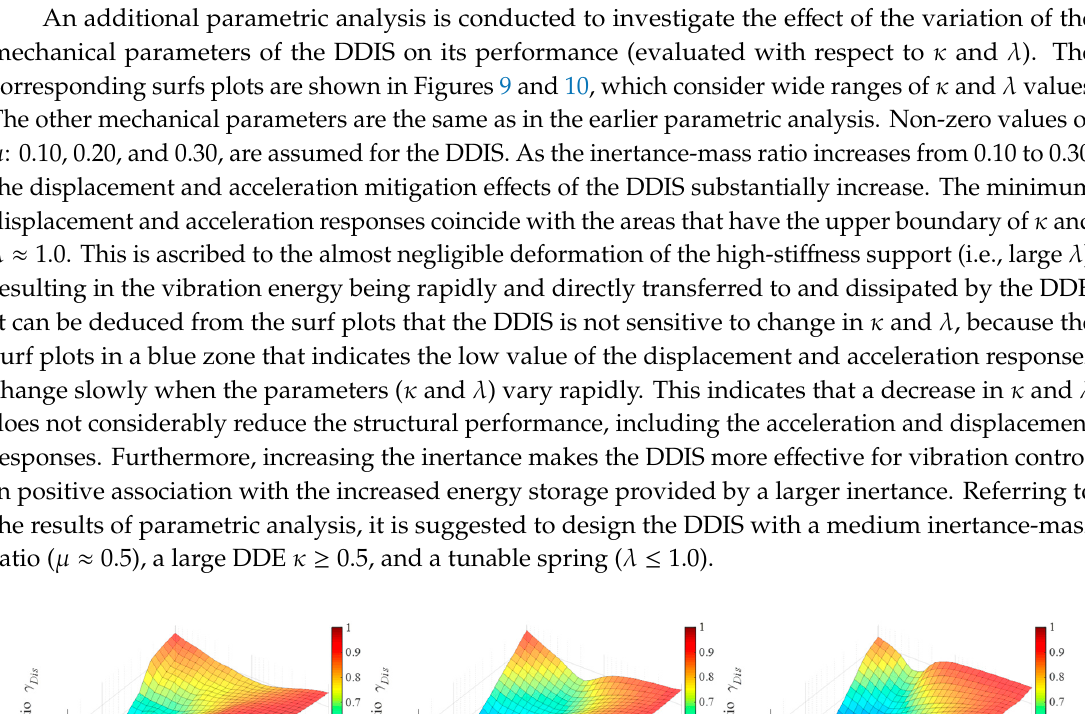
( c ) Figure 10. Variation of γ Acc for (a) μ= 0.10 , (b) μ= 0.20 , and (c) μ= 0.30 . 3.2.3. Influence of Structural Parameters Physical and model uncertainty of the primary structure may cause the practical behavior of the DDIS to deviate from theoretical expectations. The sensitivity of the vibration control effect of the DDIS to uncertainties of the primary structure is also worth analyzing. Therefore, the stiffness of the primary structure was considered to be variable owing to errors yielded by imprecise construction and deterioration during service. Figure 11 illustrates the effect of the variation of